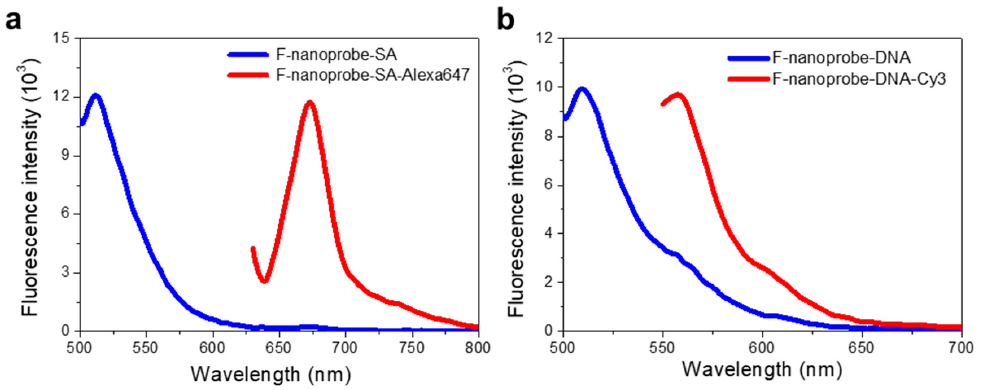
Figure 4. ( a ) Fluorescence spectra of F-nanoprobe-SA (blue) and F-nanoprobe-SA-Alex647 (red). ( b ) Fluorescence spectra of F-nanoprobe-DNA (blue) and F-nanoprobe-DNA-Cy3 (red).